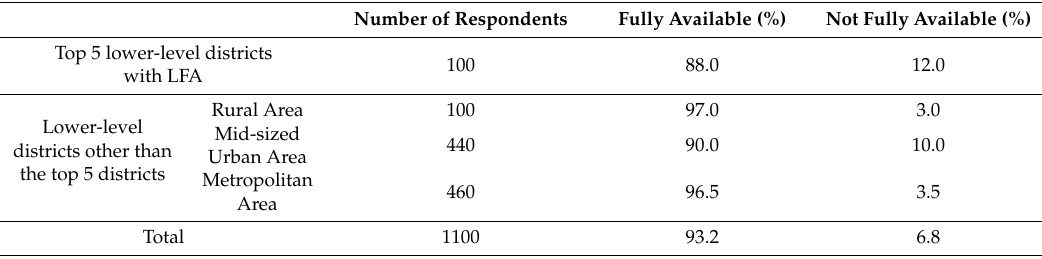
Table 9. Availability of a variety of foods required for nutritionally balanced dietary life in the grocery store that is mainly used.